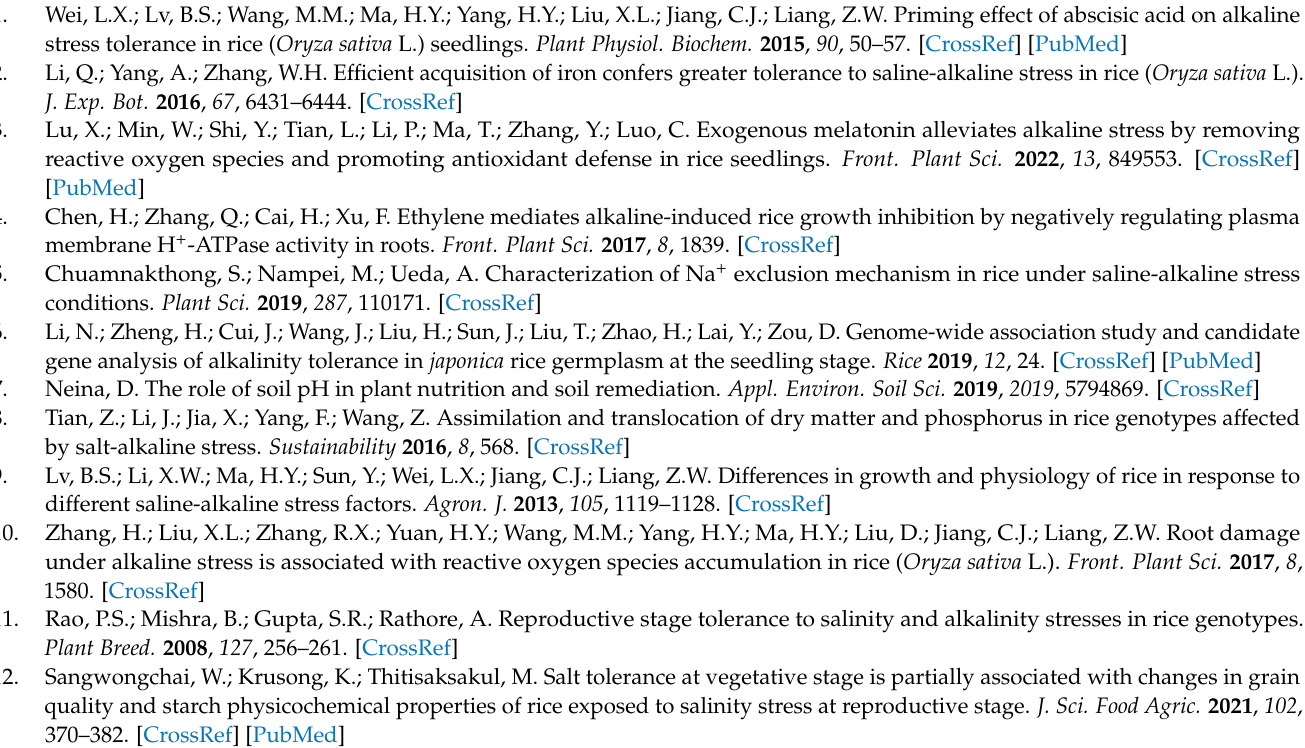
ulation; Table S2. Additive QTLs for seedling stage morpho-physiological traits under control environment identified by ICIM method in Cocodrie × Dular RIL population; Table S3. List of List of genes present in QTL intervals of alkalinity tolerance traits; Table S4. List of candidate genes with high impact variants; Table S5. Polymorphic low, moderate, and high impact variants between Cocodrie and Dular for five selected alkalinity tolerance QTLs; Table S6. List of primers used